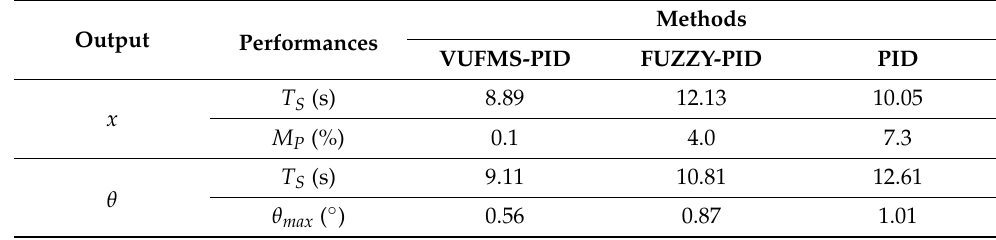
Table 7. Performances obtained using VUFMS-PID, FUZZY-PID, and PID controller under working condition